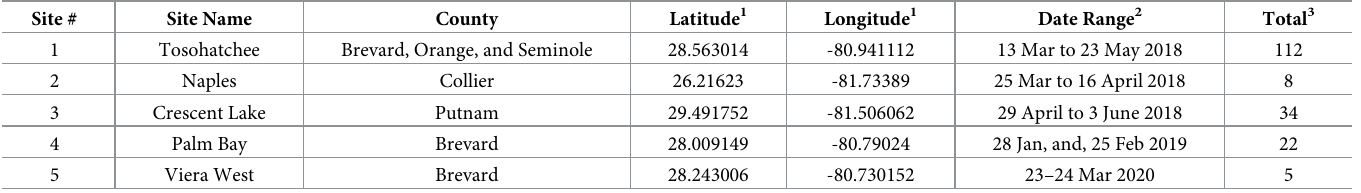
Table 1. Sites from which sick and dead freshwater turtles were examined and tested positive for Turtle fraservirus 1 during period of 13 March 2018 through 25 February 2019, and March 2020. Site